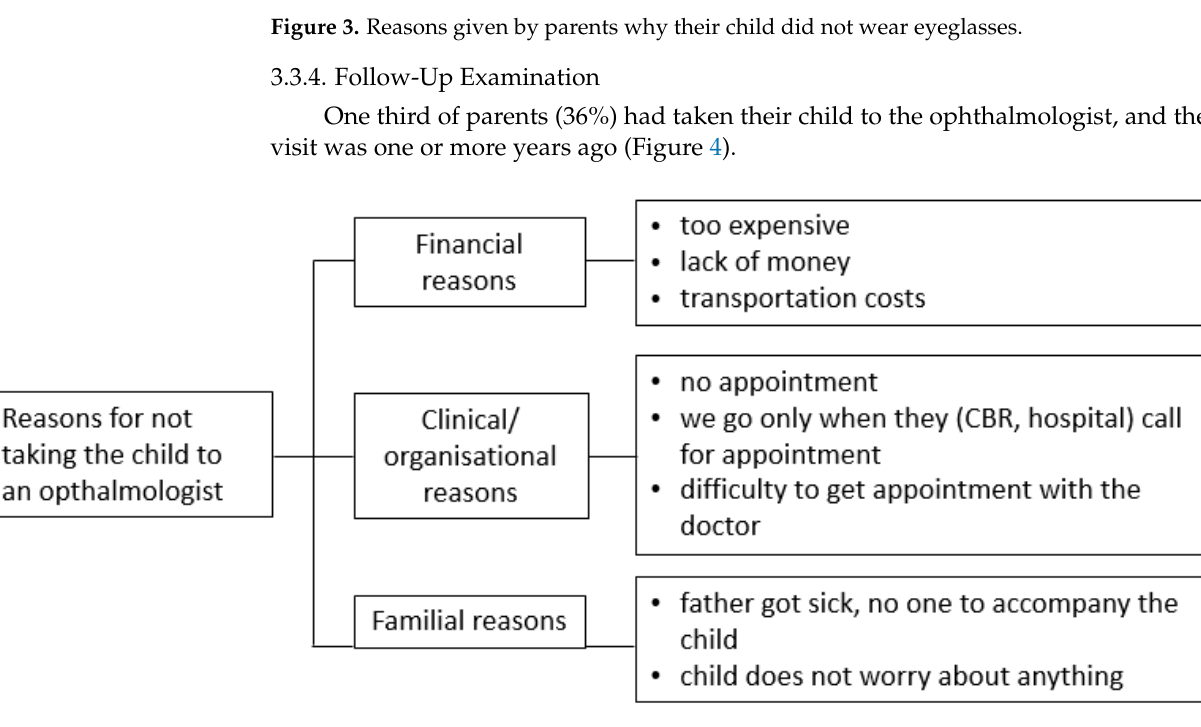
Figure 4. Reasons given by parents for not seeing an ophthalmologist after surgery.